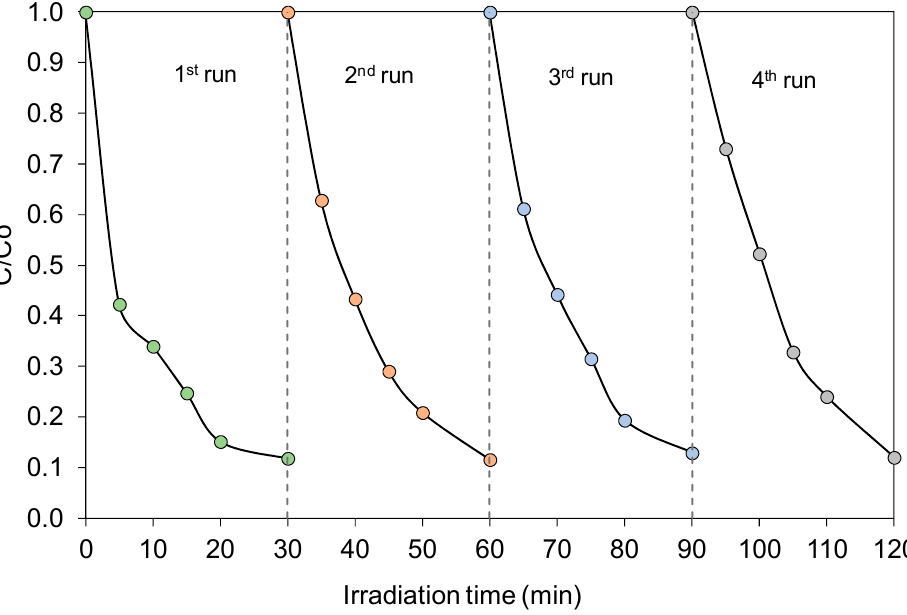
Figure 11. Efficiency of phenol degradation in the presence of CoFe 2 O 4 /SiO 2 /TiO 2 magnetic photocatalyst measured in the fourth subsequent cycles.